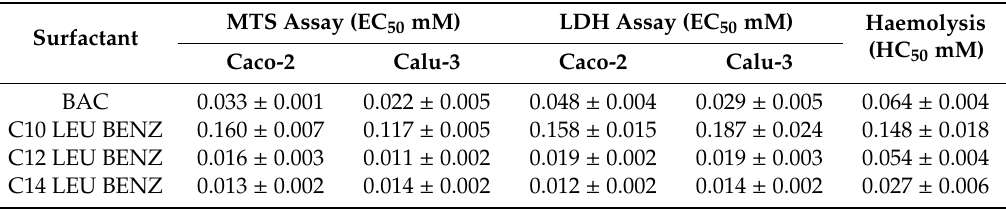
Figure 4. Haemolysis (%) after exposure of the quaternary ammonium leucine surfactants (C10 LEU BENZ, C12 LEU BENZ and C14 LEU BENZ) and the reference compound BAC. Dots represent the mean and bars the standard deviation ( n = 3). Table 3. Cytotoxicity parameters (EC 50 ) and HC 50 values of the synthesised quaternary ammonium leucine surfactants (C10 LEU BENZ, C12 LEU BENZ and C14 LEU BENZ) in comparison to BAC as determined by MTS, LDH and haemolytic assays. EC 50 is the concentration of surfactants that caused a 50% reduction of viable cells (MTT assay) or a 50% release of LDH (LDH assay). HC 50 is the concentration of surfactants that caused a 50% haemoglobin release from erythrocytes. Results are mean ± SD of at least three independent repeated experiments.